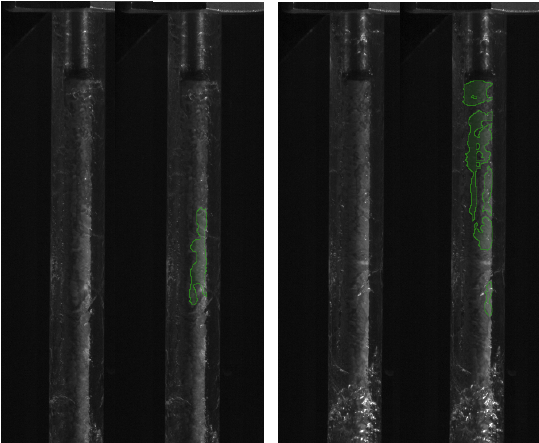
Figure 6. Glowing during CHF